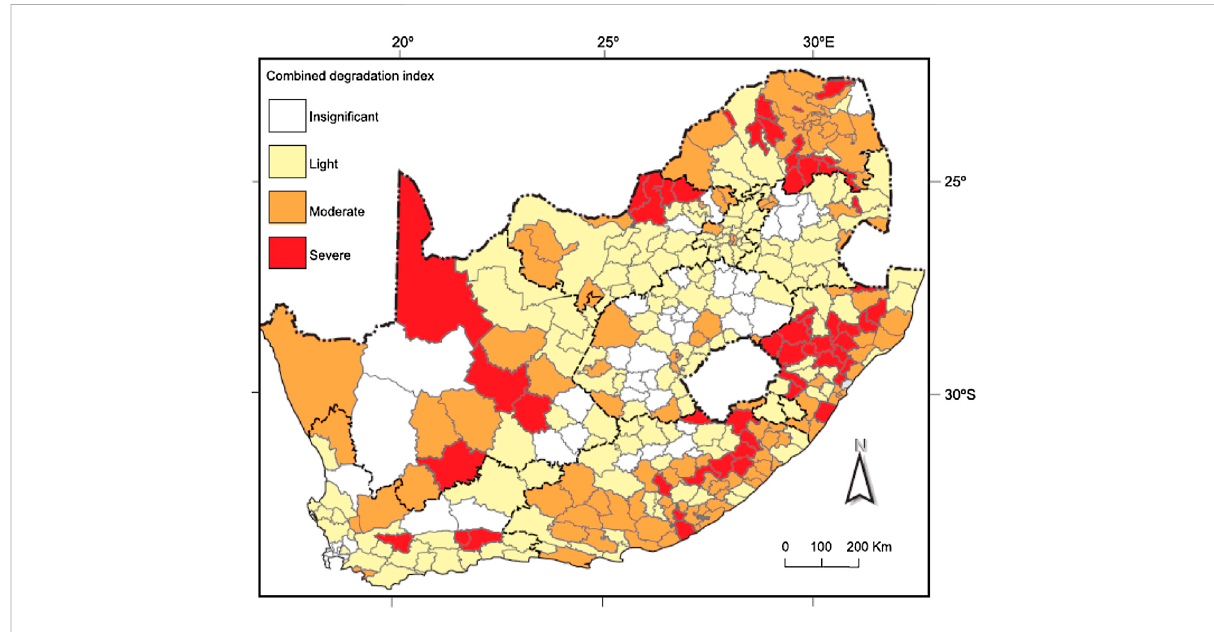
FIGURE 1 Combined degradation index of South African rangeland degradation, darker shading indicates areas with severe degradation. Adopted from Hoffman et al. (1999), Meadows and Hoffman